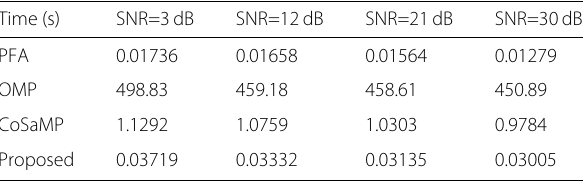
Table 2 Average running time of imaging algorithms versus different numbers of scatterers (indicated by N s